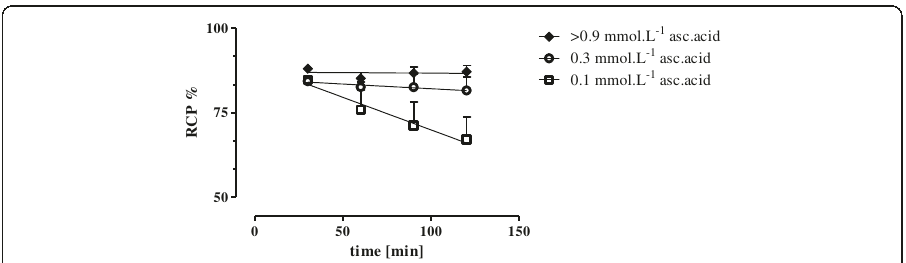
Fig. 4 Stability as function of time of 213 Bi-DOTATATE with different concentration ascorbic acid added during labelling, y-axis is RCP expressed in mean percentage± SD and x-axis time in minutes after labelling ( n ≥